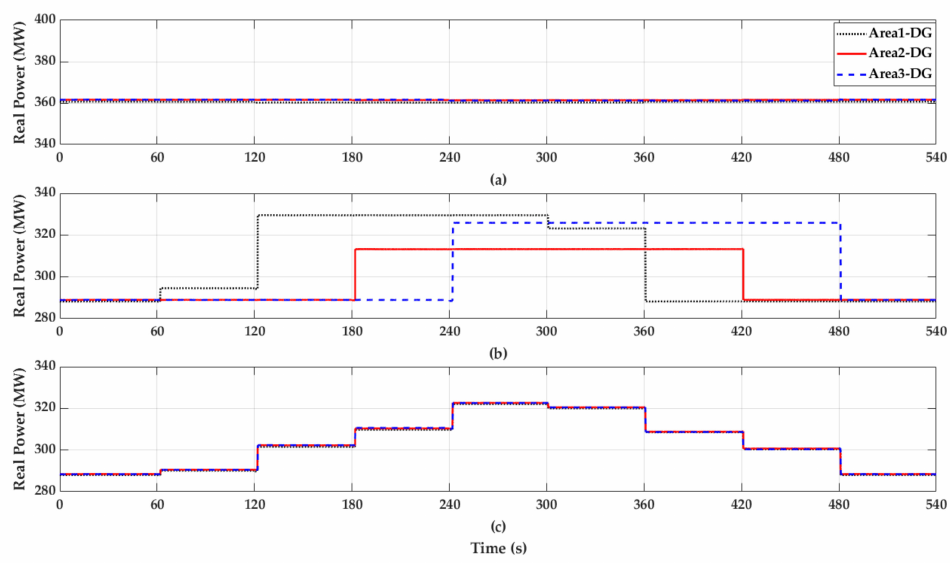
Figure 4. Real power responses of the representative CBGs with ( a ) MPPT, ( b ) VMS droop control, and ( c ) balanced response